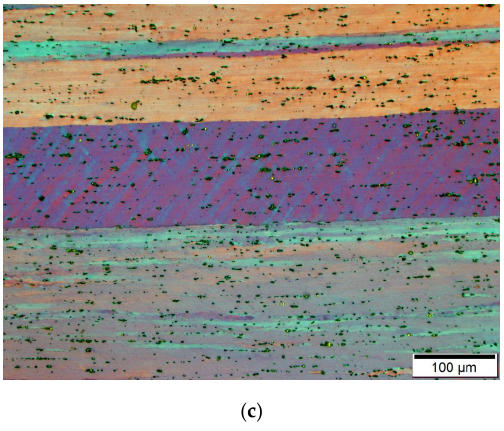
Figure 7. AlZn6Mg0.8Zr alloy subjected to LTMP with degree of deformation of: ( a ) 10%; ( b ) 20%; ( c ) 30%.